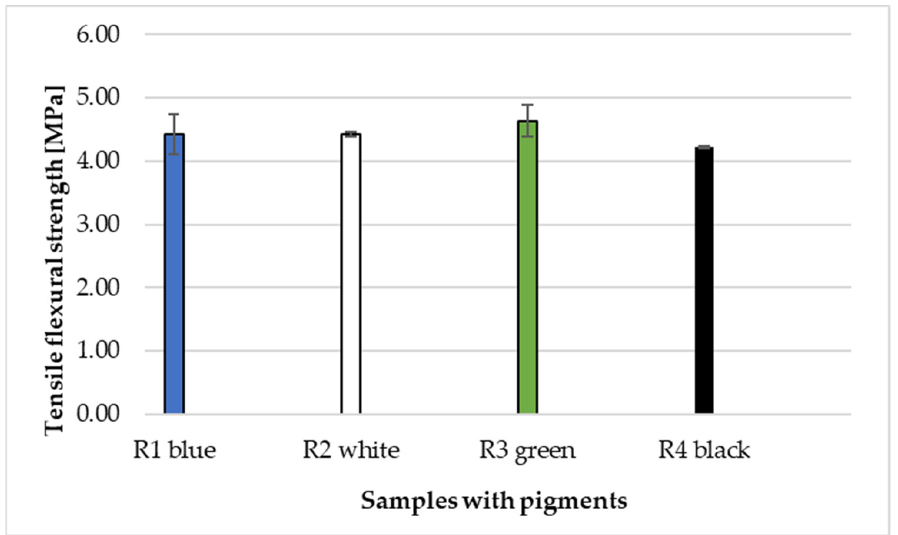
Figure 13. Flexural strengths of composites according to recipes R1–R4 with addend pigment.